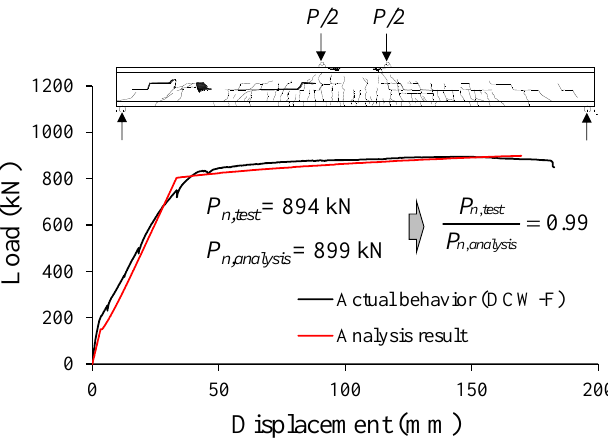
Figure 11. Comparison of the test and analysis results (DCW-F specimen).